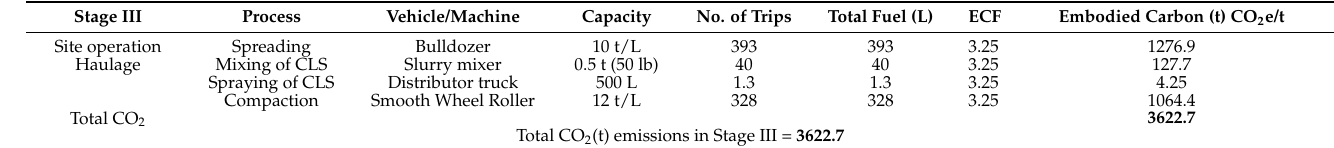
Table 6. Evaluation of carbon emissions from site